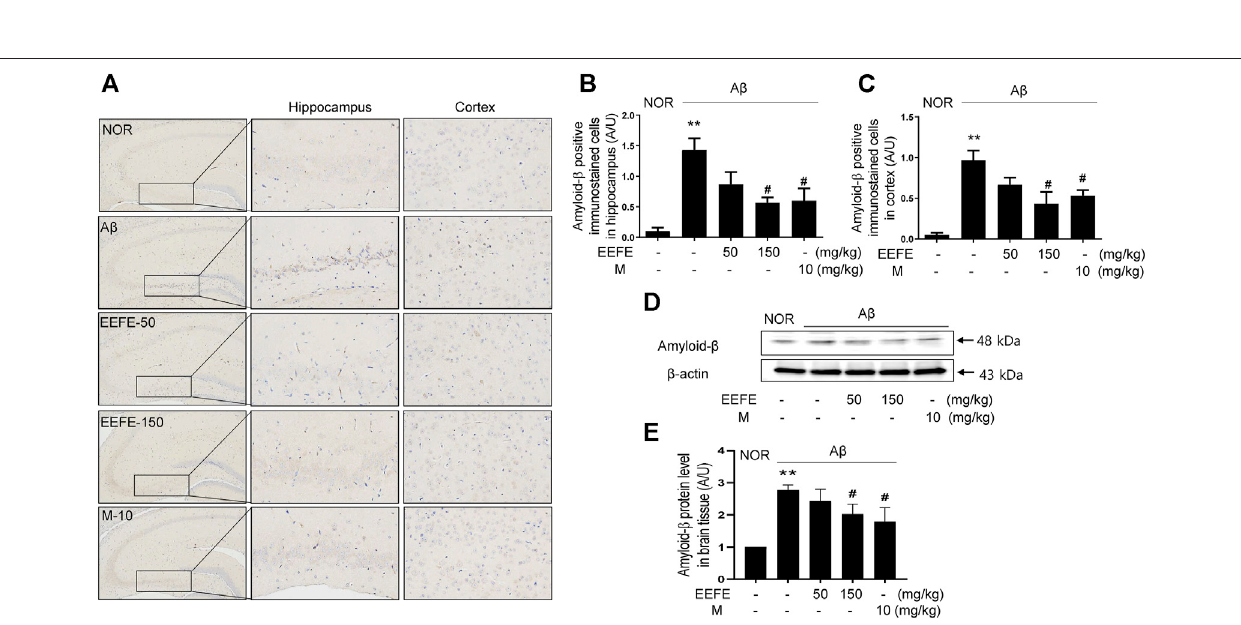
FIGURE 3 | Effects of EEFE on amyloid- β (A β ) aggregation in A β -injected mice. (A) Multiple 4- μ m paraf fi n sections of hippocampus and cortex regions were preparedfromthesacri fi cedmousebrains( n (cid:1) 3/group).A β expressionwasdeterminedbyimmunohistochemistrywithA β